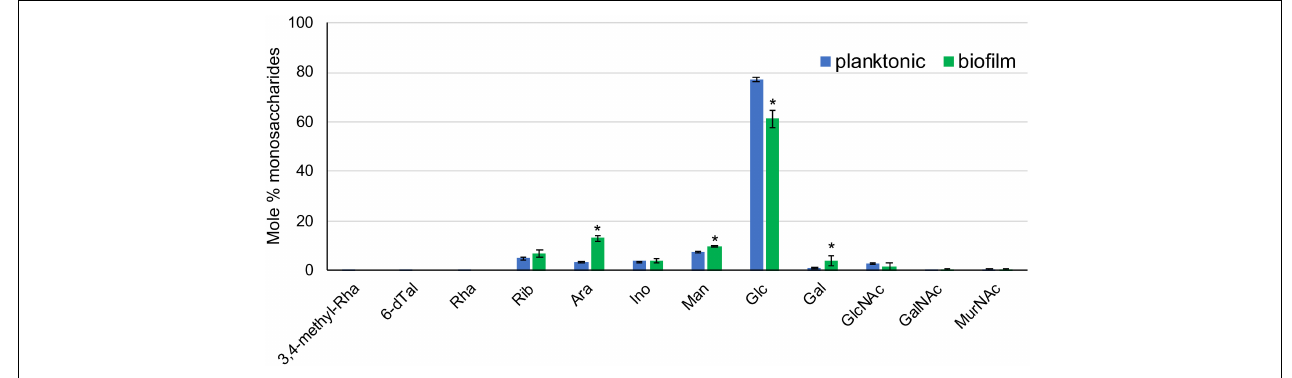
FIGURE 4 | Sugar composition of the ECM from planktonically grown and biofilm-grown Mabs NJH12. Monosaccharidic composition of Mabs NJH12 planktonic and biofilm extracellular matrices. The reported values are averages ± standard deviations of three biological replicates and represent relative mole percentages. Asterisks denote statistically significant differences between the two culture conditions pursuant to the Student’s t -test ( p < 0.05).